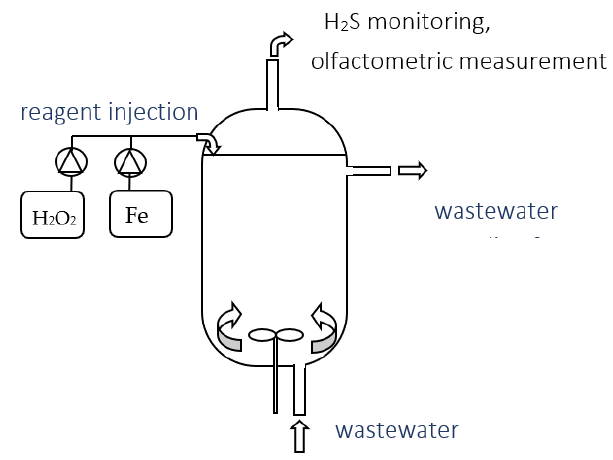
Figure 1. Diagram of the anaerobic reactor used in the experiment.